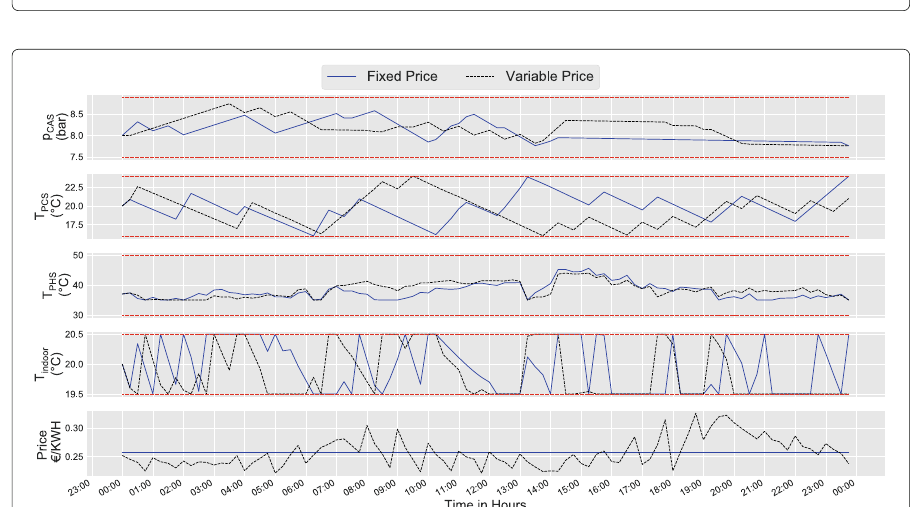
Fig. 8 State variables for the components inside TBS systems for both fixed and variable price